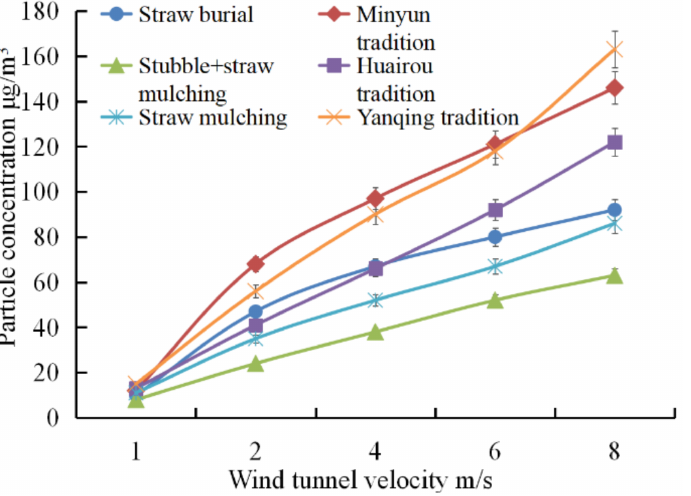
Figure 26. PM10 concentration changes with wind speed at 10 cm height in the wind tunnel.